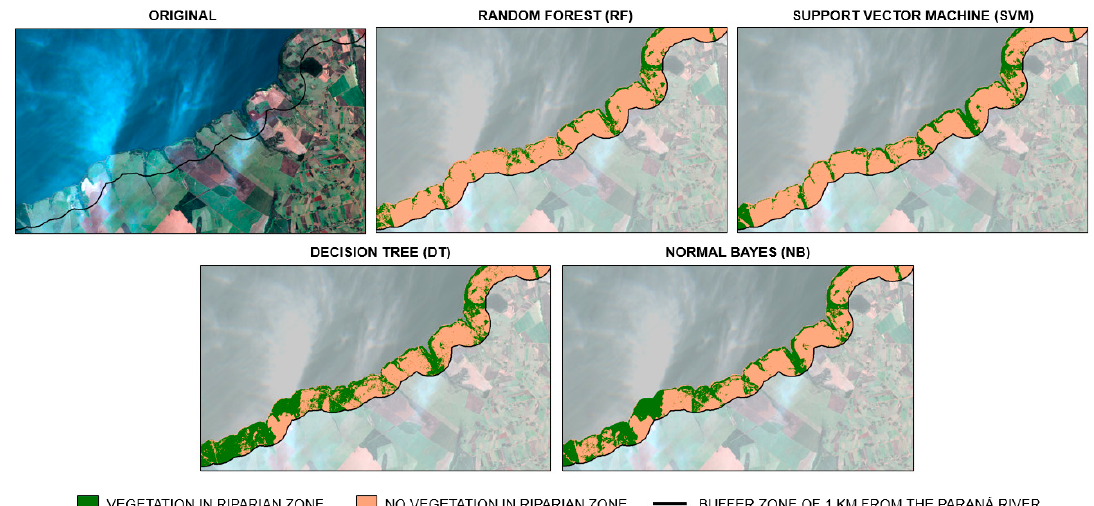
Figure 8. Examples of the classification results obtained with the algorithms using the Sentinel-2 image with the partially-cloudy area.